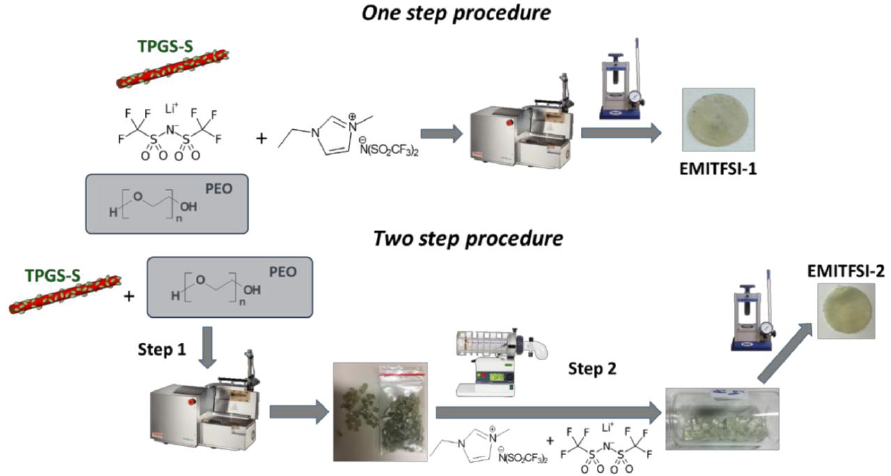
Figure 5. Extrusion processes used by Tiemblo’s group for hybrid polymer electrolytes of poly (ethylene oxide) (PEO), EMITFSI (or PYR 14 TFSI), LiTFSI, and surface-modified sepiolite (TPGS-S). The one step procedure consists of mixing and extruding all the components together while the two-step procedure begins with the extrusion and pelletization of PEO and sepiolite which is followed by swelling the pellets in a liquid mixture of EMITFSI + LiTFSI. Reprinted with permission of Polymers 2019, 11, 406 [49].